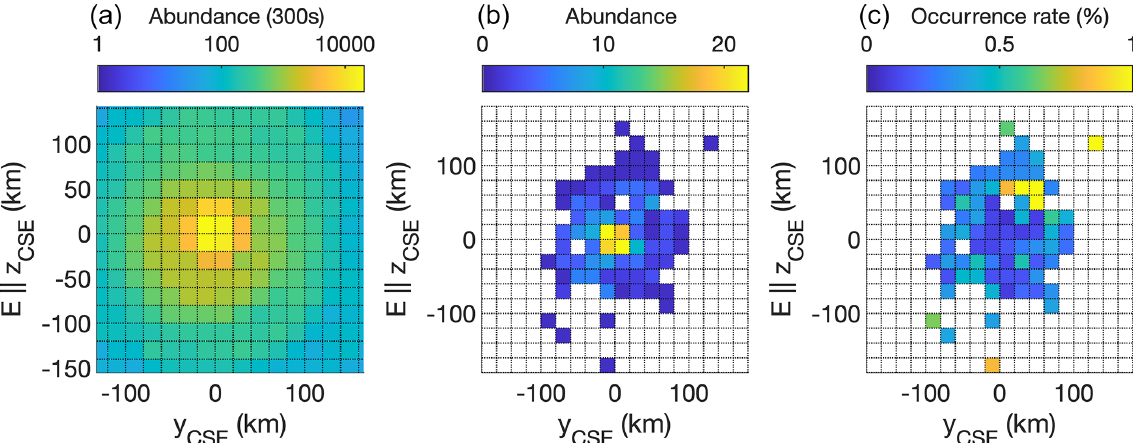
Figure 4. Abundance of the position of the spacecraft (a) , position at which warm protons were detected (b) and occurrence rate of detections normalized to the spacecraft dwell time (c) . The + E c hemisphere is that of z CSE > 0.